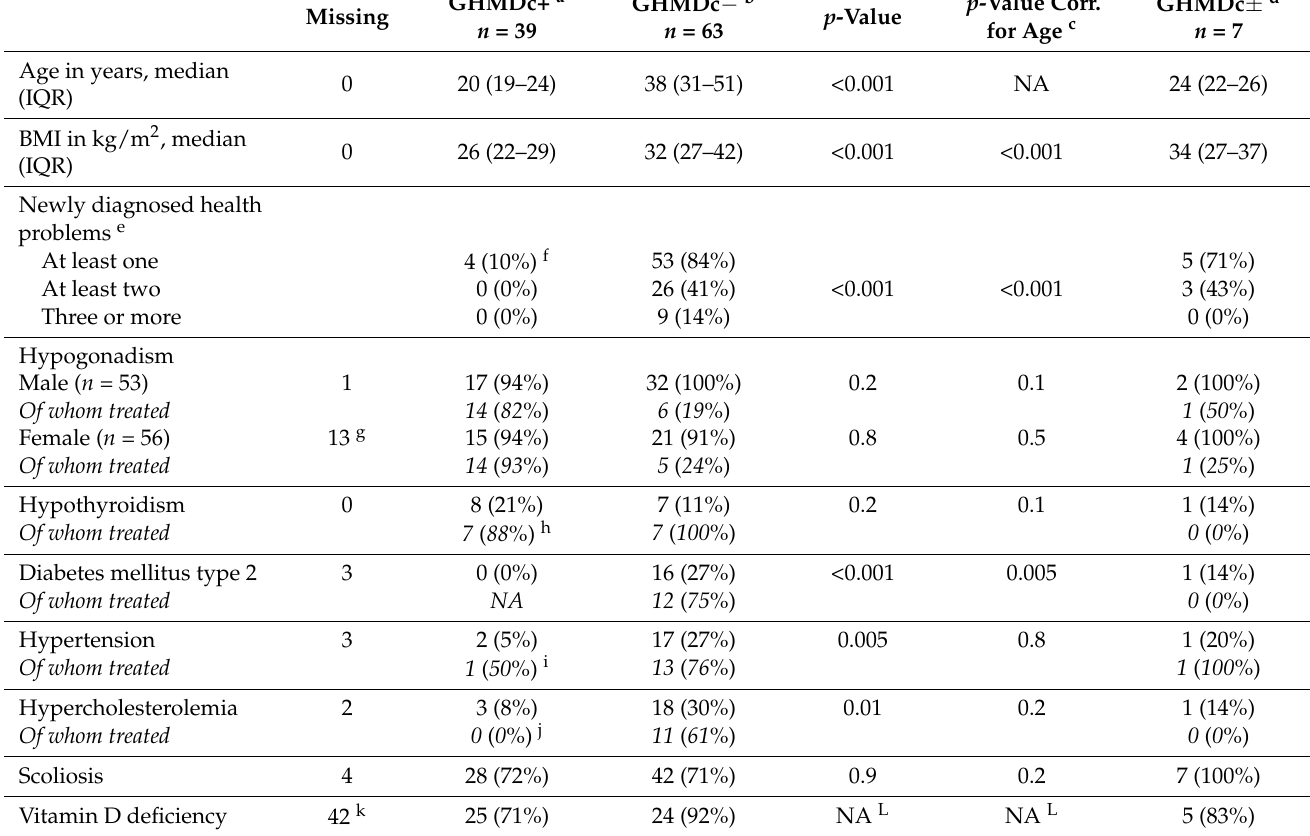
Table 2. Health problems according to GHMDc